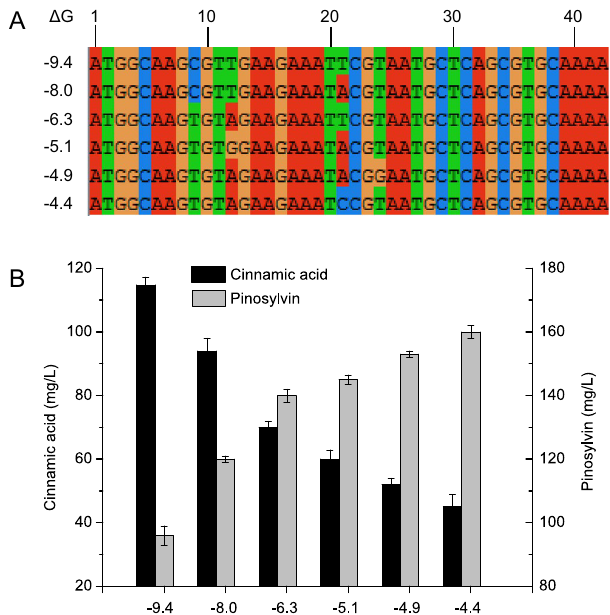
Figure 7. The effect of reducing 5 ′ region of STS mRNA secondary structure on pinosylvin production. ( A ) The alignment of different STS variant sequences ( + 1 to + 42). ( B ) Effects of differences in STS variant on pinosylvin and cinnamic acid concentrations. Numbers such as − 9.4, − 8.0 denoted Δ G of 5 ′ region of STS mRNA secondary structure. Δ G of original STS was − 9.4 kcal/mol.